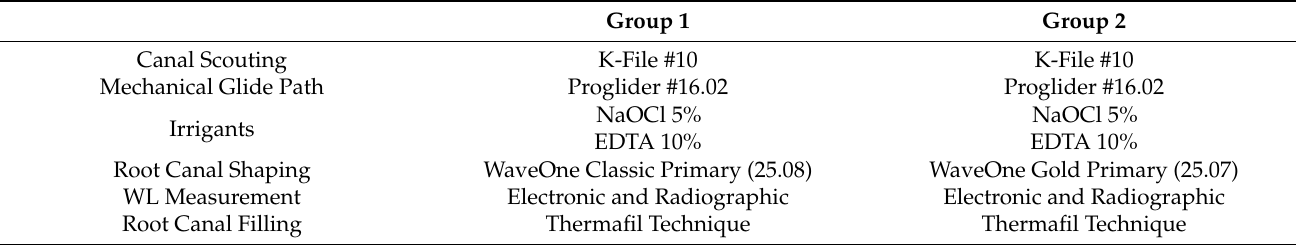
Table 1. Root canal